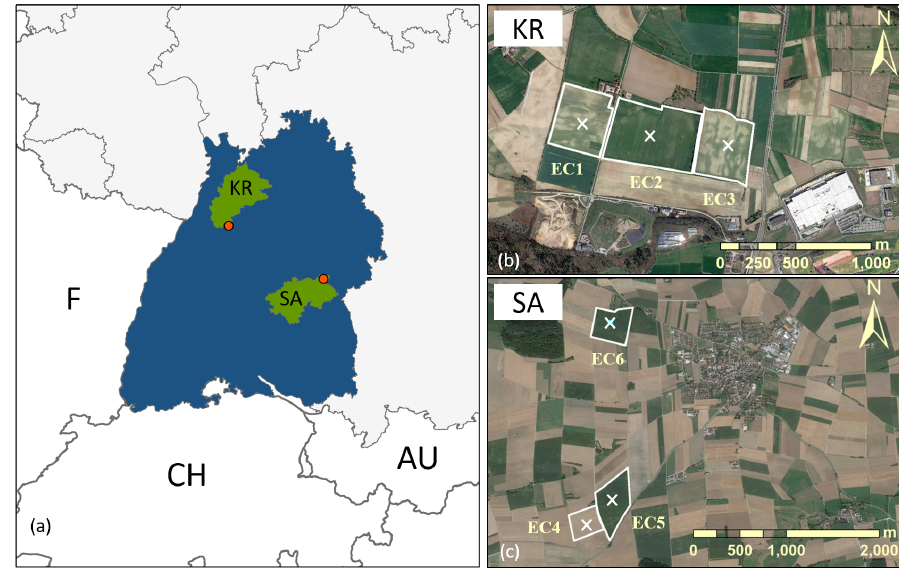
Figure 3. (a) Geographical overview and locations of the study sites and EC stations in (b) Kraichgau (KR) and (c) the Swabian Alb (SA; modified from Eshonkulov et al., 2019; © Google Earth: KR on 31 March 2017 and SA on 26 August 2016).